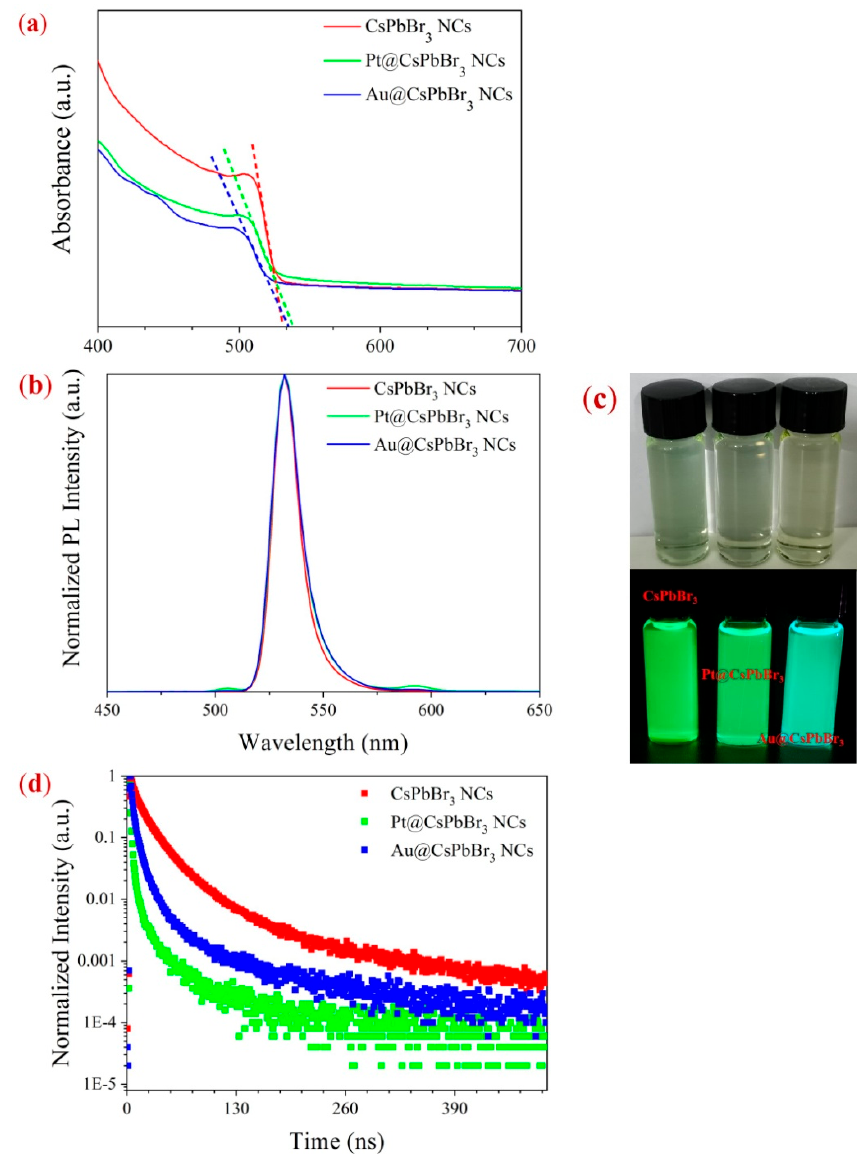
Figure 6. ( a ) Absorption and ( b ) photoluminescence (PL) spectra and ( c ) photographs and ( d ) time-resolved PL (TRPL) decay curves of different NC suspensions. Photographs were taken under daylight (top) and UV-light illumination (bottom). Table 1. Fitting parameters for TRPL spectra shown in Figure 6d.